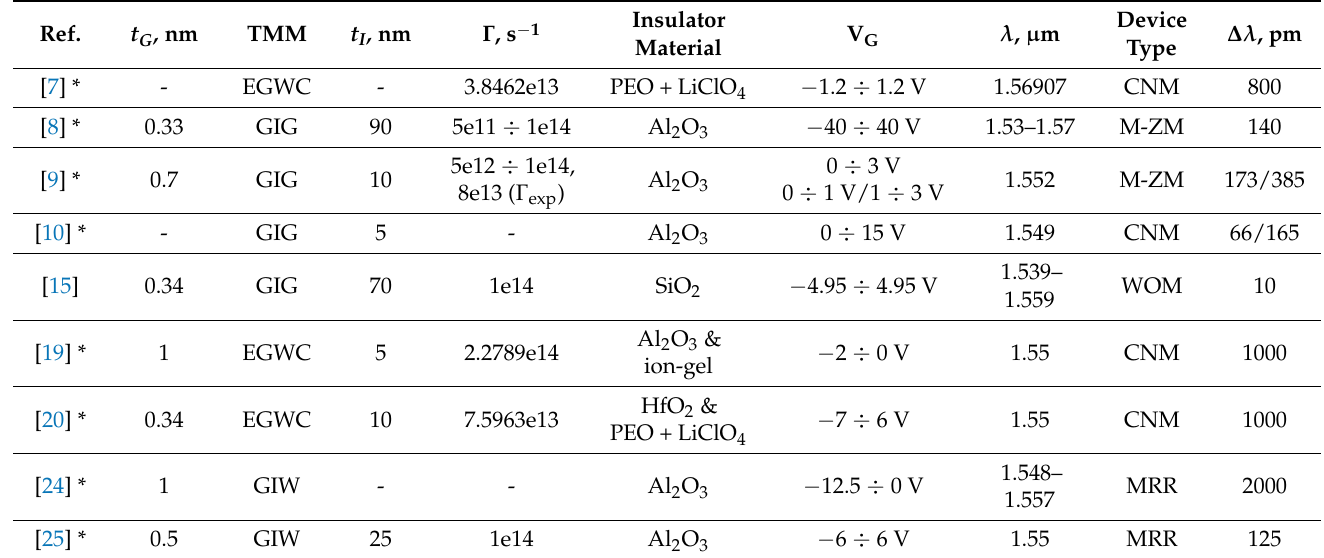
Table 2. Comparison table (* refers to fabricated